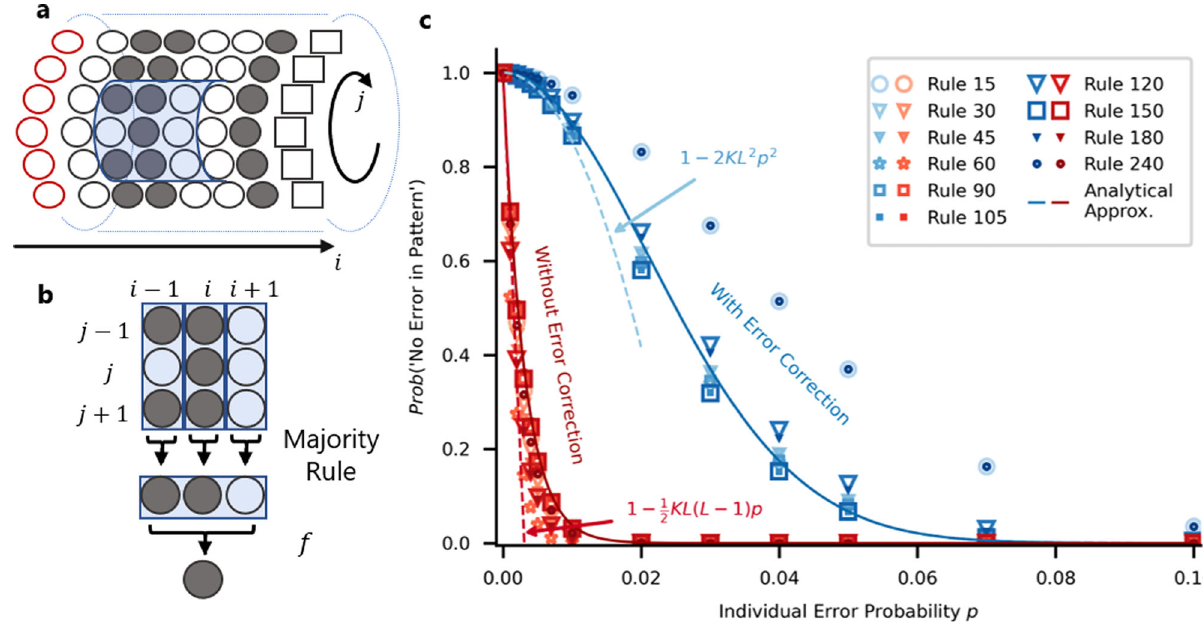
Fig. 5 Robustness against errors and error correction. a To explore a mechanism for error correction, we consider a cylindrical system with an array of organizer cells (white cells with red border) along the left edge and a fi xed boundary condition (white squares) along the right edge. Cells are indexed by i in horizontal direction and j in vertical direction. The update rule now takes input from a nine-cell neighborhood (shaded blue). b Given a nine-cell neighborhood, the update rule applies ‘ majority voting ’ in the vertical direction (index j ), establishing a consensus triplet to which one of the 1D programmable rules f is applied, yielding the fi nal output. c Computer simulations (symbols) and analytical theory (lines) for systems with error correction by majority voting (blue) compared to the case without error correction (red). Circles indicate rules insensitive to the initial condition, triangles nonlinear rules, squares both sides bijective rules and stars the remaining rule (cp. Fig. 2e). In each case, a system of horizontal and vertical size of L ¼ K ¼ 9 was used. After each update cells switch to a different state with probability p . Suf fi cient simulation runs were performed to estimate the plotted probability of arriving at the correct fi nal pattern with a statistical error smaller than the symbol size (see ‘ Methods ’ ). Convergence is demonstrated by the observation that rules for which the same error behavior is expected (Rules 15 and 240) yield data points lying on top of each other. See Supplementary Note S4 for the analytical approximations and Supplementary Fig. S14 for a corresponding analysis of a planar